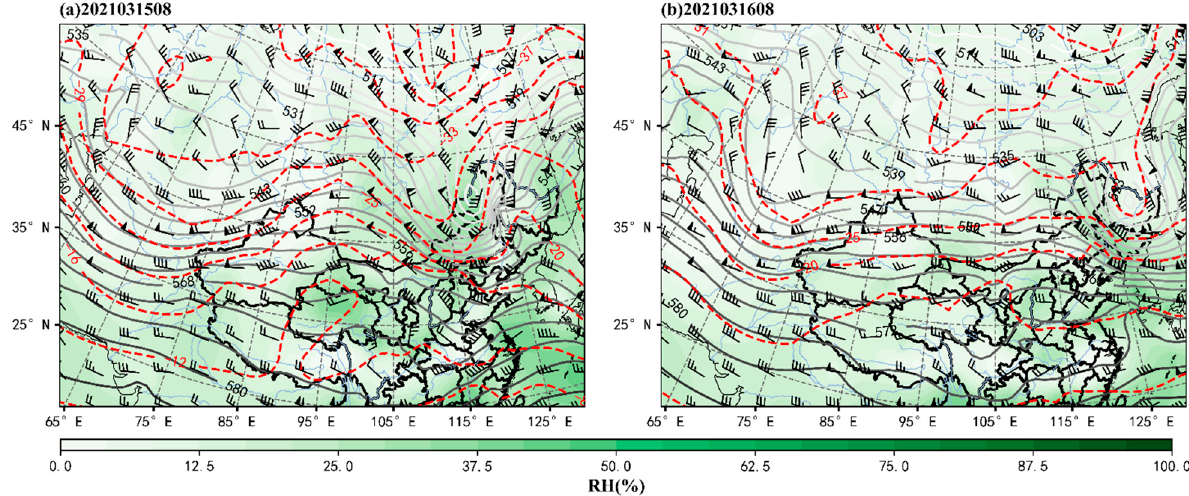
Figure 6. Superposition diagram of geopotential height (black contours), temperature (red iso- therms), wind field, and relative humidity at 500 hPa. ( a ) 08:00, 15 March 2021; ( b ) 08:00, 16 March 2021.